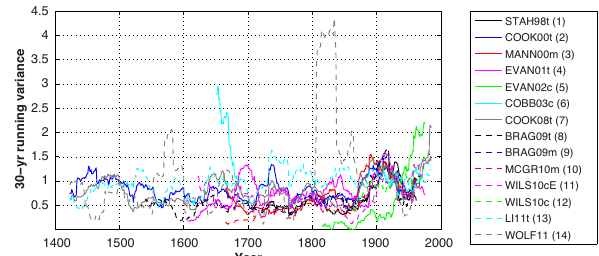
Figure 1: The running variance of each of the 10-yr high-pass filtered ENSO reconstructions (reconstruction names and numbers correspond to those in Table 1). Note the individual reconstruction time series were normalized over the period 1900-1977 prior to calculating the running variance in a 30-yr sliding window. Each running variance time series is then adjusted by adding a constant, such that their mean running variance over the period 1900-1977 matches that of the observed ENSO signal (defined as high pass filtered surface temperature averaged over the Niño 3.4 region) over the same period.